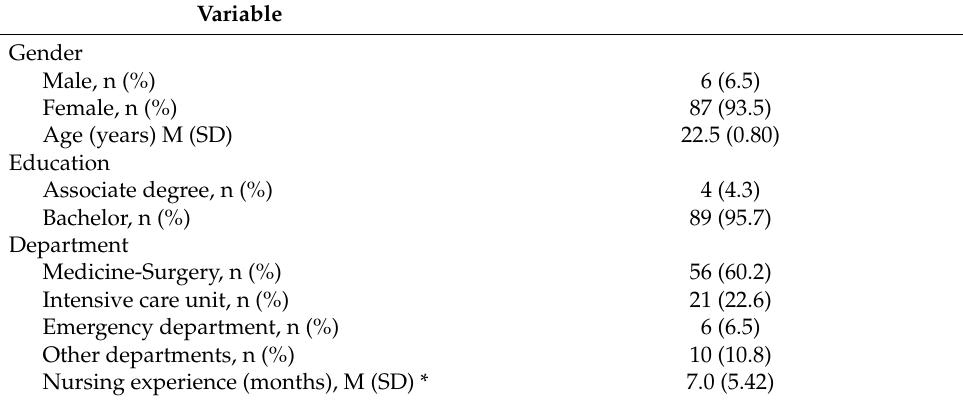
Table 2. Demographic data of participants ( N = 93).